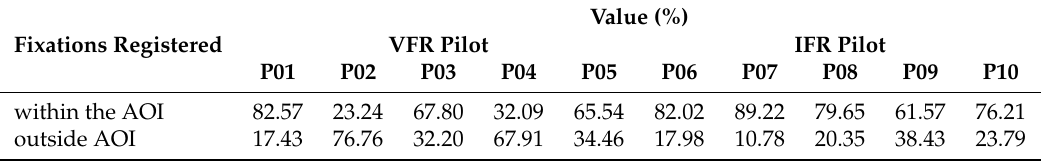
Table 8. Percentage contribution of fixations for the measurements with sharp instrument outlines.